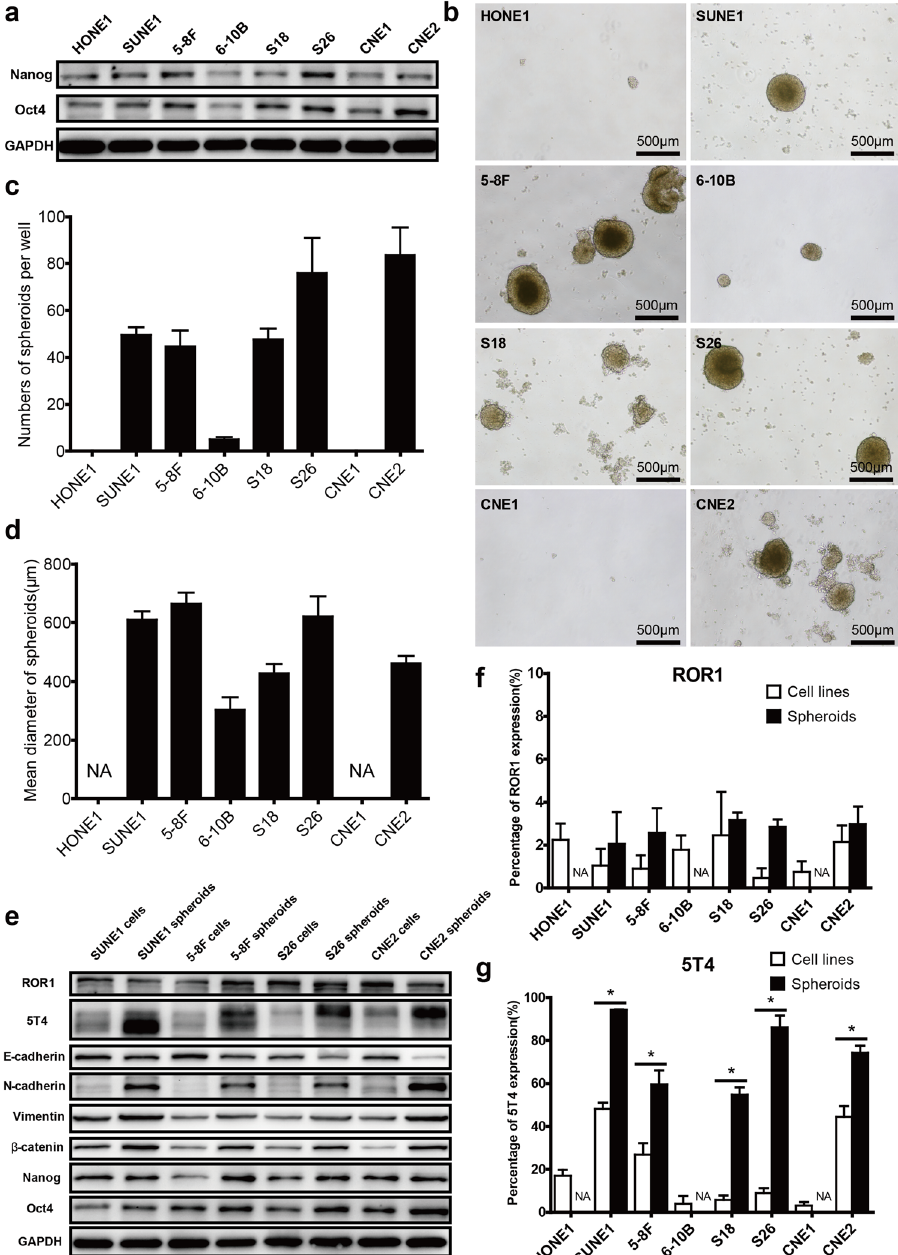
Figure 3. 5T4 expression is correlated with stemness features in NPC. ( a ) WB analysis of Nanog and Oct4 expression in eight NPC cell lines was performed through staining with the corresponding antibodies. The results shown are representative of three independent experiments. ( b ) The self-renewal capability of eight NPC cell lines was assessed with sphere formation assays. NPC cells were seeded at a density of 1,000 cells per well in triplicate and induced to spheroids. A typical image of each type of spheroid on day 7 of culture is presented. ( c ) The number of each type of NPC spheroid was calculated and is presented as the mean ± SD of triplicate wells. ( d ) The diameter of each type of NPC spheroid was measured, and the results are displayed as the mean ± SD of five randomly selected spheroids. The experiment was repeated three times. ( e ) The expression levels of ROR1, 5T4 and a series of EMT and stemness-associated markers in NPC cell lines and the resultant spheroids were examined using WB with specific antibodies. The results shown are representative of three independent experiments. Membrane expression of ROR1 ( f ) or 5T4 ( g ) on NPC spheroid cells and their parental cells was analysed using FACS with APC-conjugated specific antibodies or matched isotype control antibodies, respectively. Data are shown as the mean ± SD of triplicate experiments. NA: not available. * indicates p < 0.05 (two-tailed Student’s